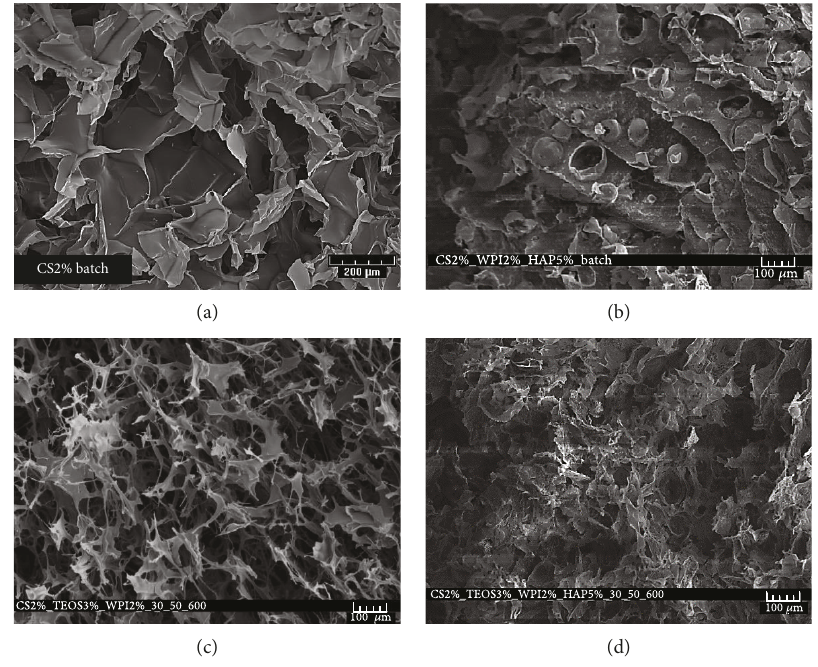
Figure 4: SEM micrographs of the various formulated sca ff olds obtained by batch or continuous process ( L = 30 mL min − 1 , G = 50 mL min − 1 , and N = 600 rpm ). (a) CS formulation in the batch process, (b) CS/WPI/HAp formulation in the batch process, (c) CS/WPI/SiO formulation in the continuous process, and (d) CS/WPI/SiO /HAp in the continuous process. CS: chitosan; WPI: whey protein isolate; 2 HAp: hydroxyapatite; L : liquid fl ow rate; G : gas fl ow rate; N : rotating speed.